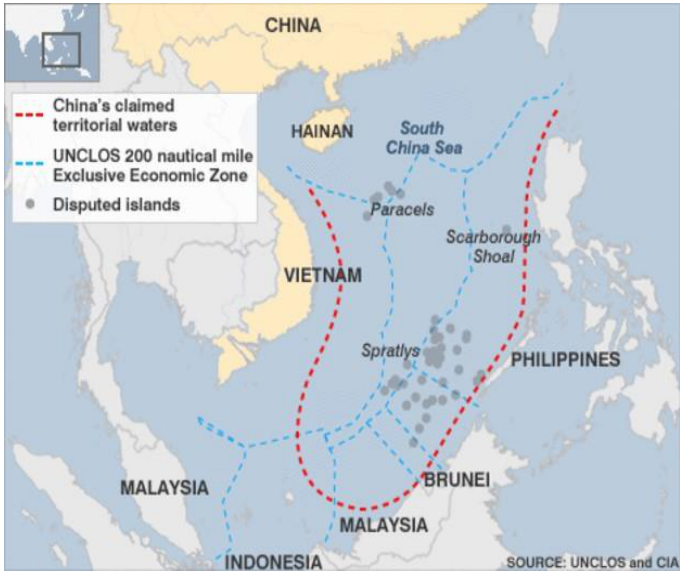
Figure 2: Nine Dash Line Claim